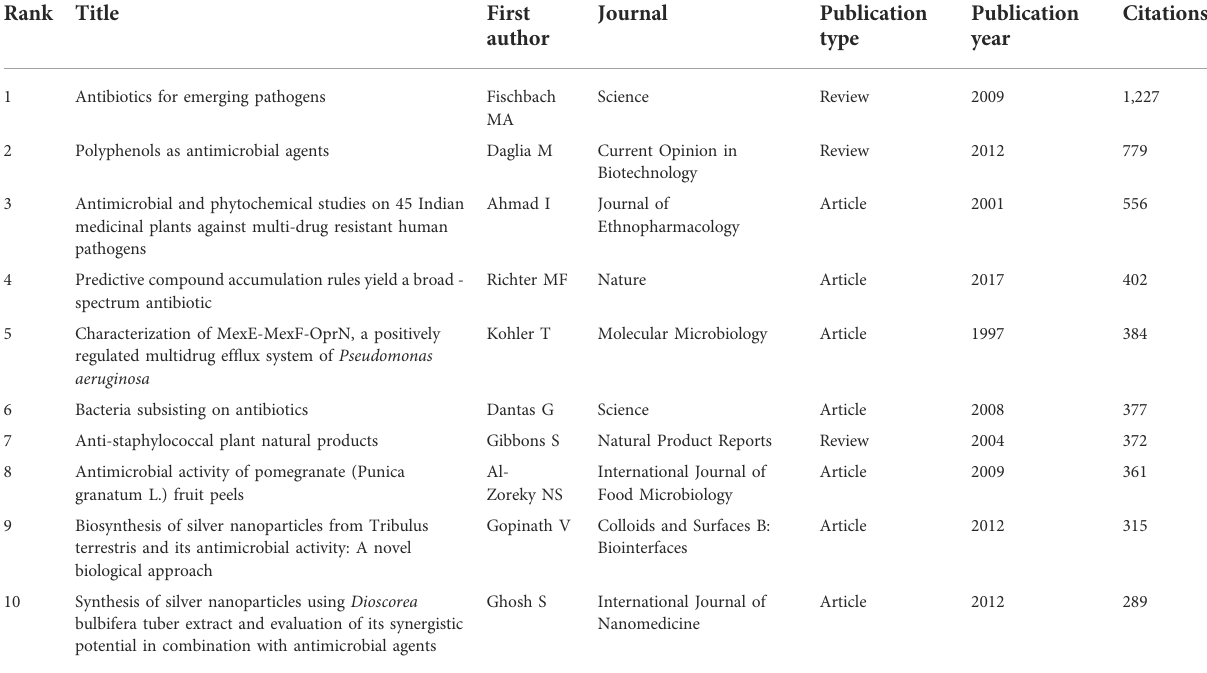
TABLE 4 The top 10 most-cited papers related to resistance of natural products to MDR